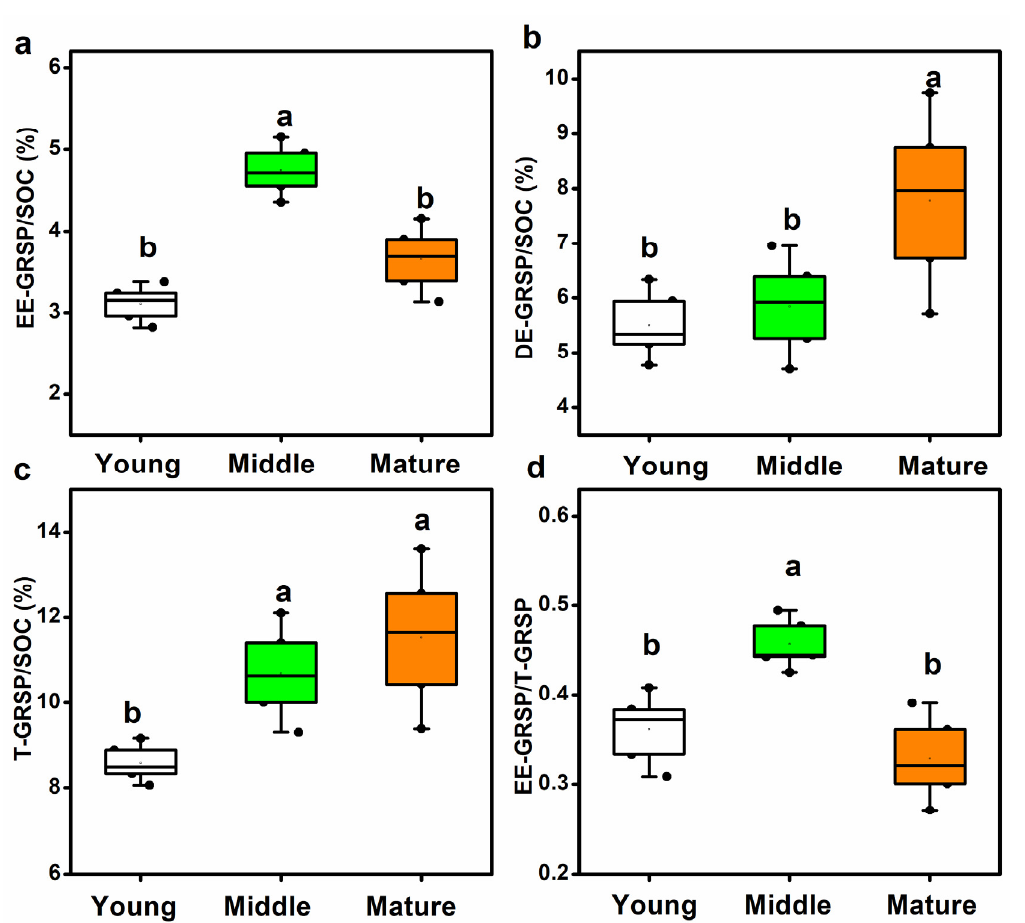
Figure 1. Total colonization rate ( a ), spore density ( b ), GRSP contents ( c ) and AM fungal biomass ( d ) in different C. lanceolata plantations. Bars topped by different letters indicate significant differ- ence ( p < 0.05).